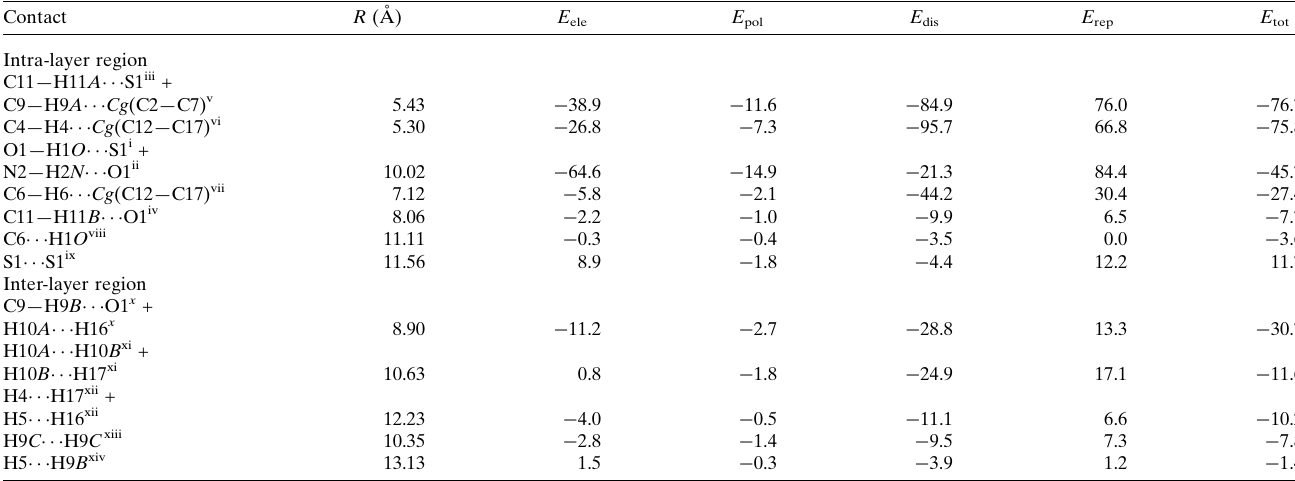
Table 4 A summary of interaction energies (kJ mol (cid:3) 1 ) calculated for (I). Contact R (A˚ ) E ele E pol E